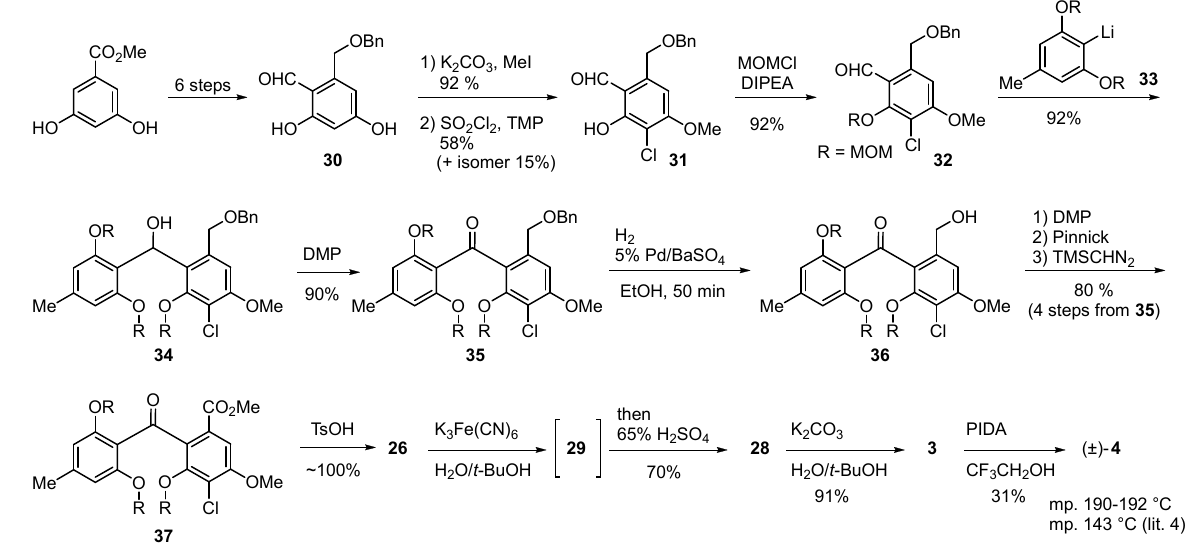
Scheme 4. Total synthesis of pestheic acid and rac -maldoxin by Yu and Snyder.